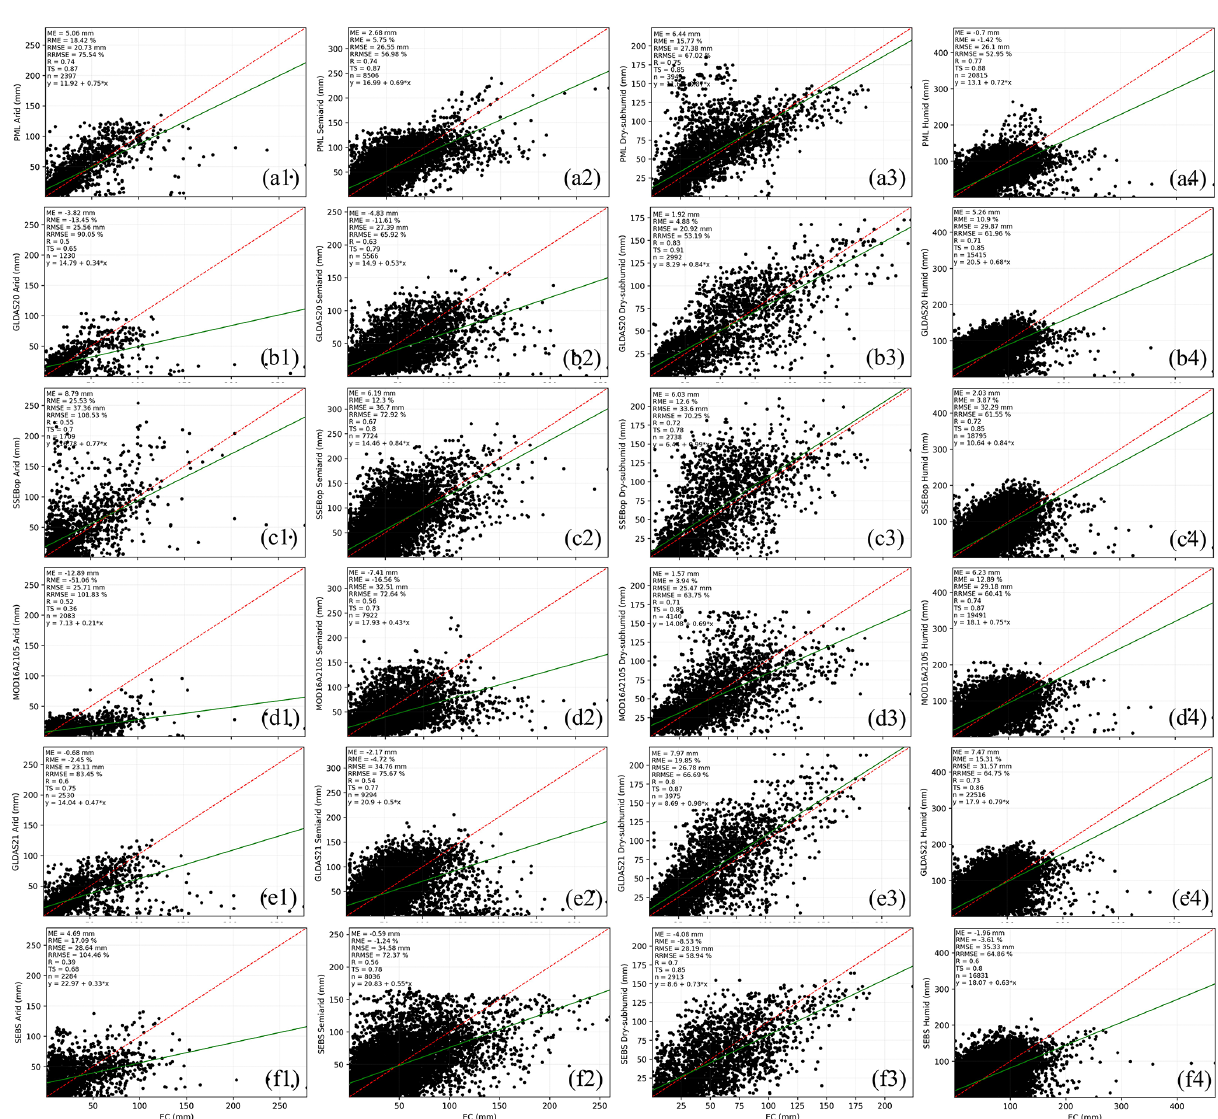
Figure 9. Monthly ET products (PML: a ; GLDAS20: b ; SSEBop: c ; MOD16A2105: d ; GLDAS21: e ; SEBS: f ) against flux EC ET aggre- gated for all sites for each climate class (arid: 1; semiarid: 2; dry subhumid: 3; humid: